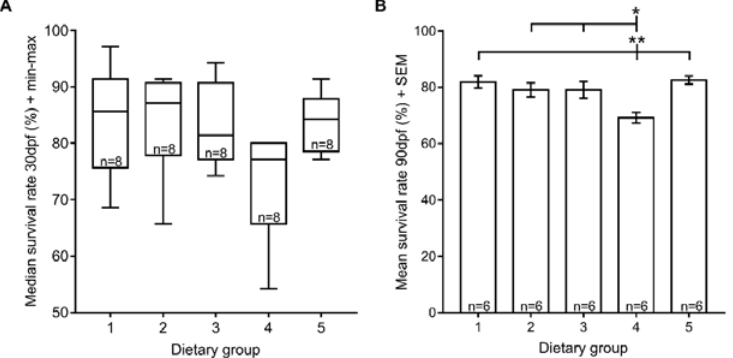
Figure 1. Zebrafish survival rates under the five different dietary regimens. ( A ) Median survival rate at 30 dpf; ( B ) mean survival rate at 90 dpf. Statistically significant differences in survival rates depicted: * p < 0.05, ** p < 0.01. Dietary Groups (Zeb = Zebrafeed ® ; Gem = GemmaMicro ® ; Rot =